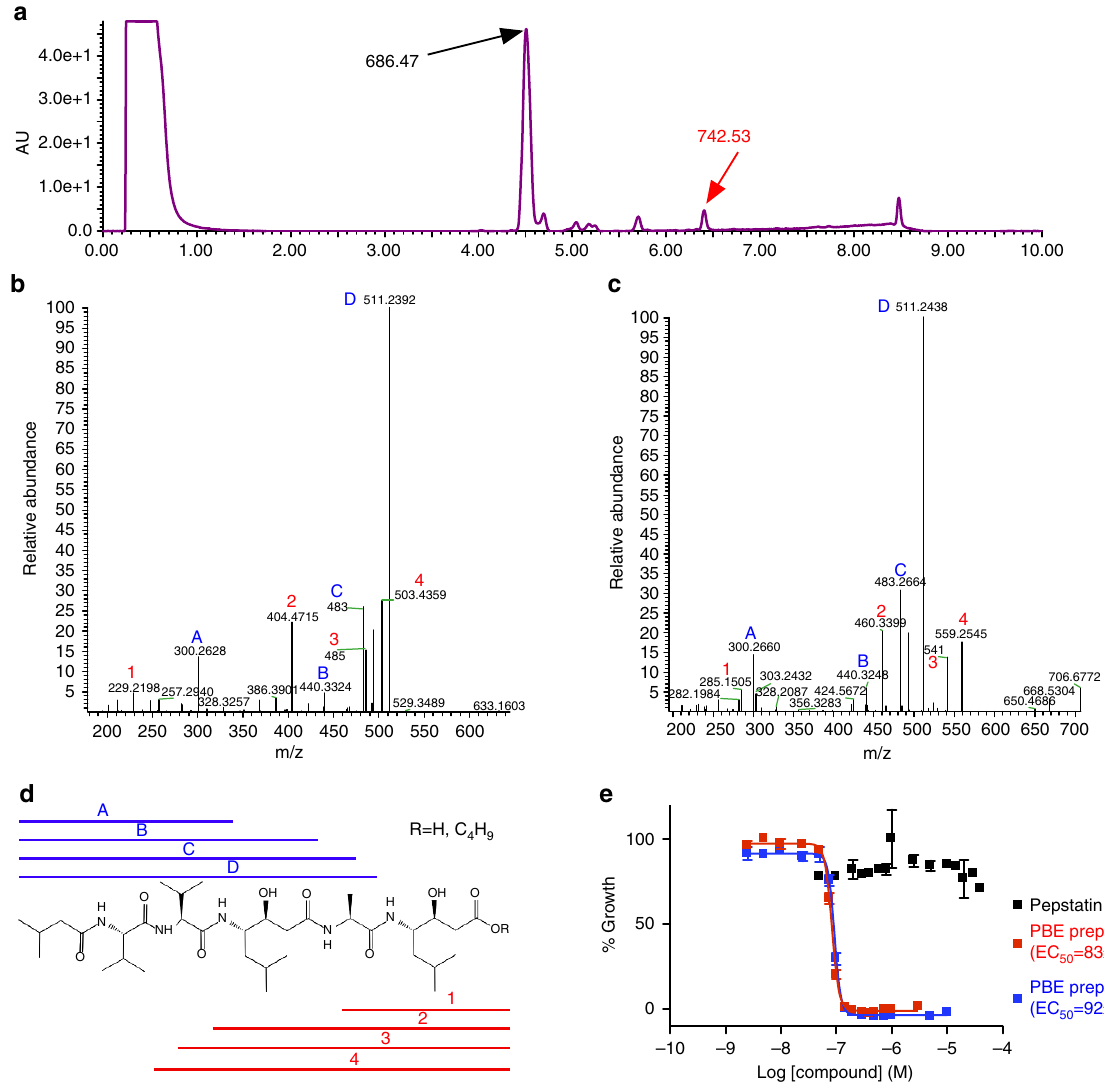
Figure 1 | Potent pepstatin preparations contain pepstatin esters. ( a ) Separation of older, potent pepstatin by C18 reverse phase chromatography. The prominent peak eluting at 4.5min has a mass of 686.47 and does not kill malaria cultures at 40 m M. The minor peak eluting at 6.4min has a mass of 742.53 and is highly potent. ( b , c ) MS/MS fragmentation of the 686.47 mass peak ( b ) and the 742.53 mass peak ( c ). Mass-to-charge ratios (m/z) of selected fragments are indicated in black numbers. The blue letters and red numbers match fragments of the structure key in ( d ). ( d ) Structure and MS fragmentation key of pepstatin or pepstatin ester. Blue lines and letters mark N-terminal fragments present in the free acid or ester of pepstatin. Red lines and numbers show C-terminal fragments which have an additional 56amu in the pepstatin ester. (Note that there is loss of a proton on pepstatin upon the addition of the C 4 H 9 ester). ( e ) Concentration responses of blood-stage 3D7 parasites (all in 0.1% DMSO) with pepstatin (black) or two syntheses of pepstatin n-butyl ester (PBE) (red, blue) measured using a flow cytometry-based assay. PBE inhibition data were fit to a sigmoidal growth inhibition curve. Error bars show s.d. ± indicates standard errors calculated for the biological triplicates of the experiment shown. N ¼